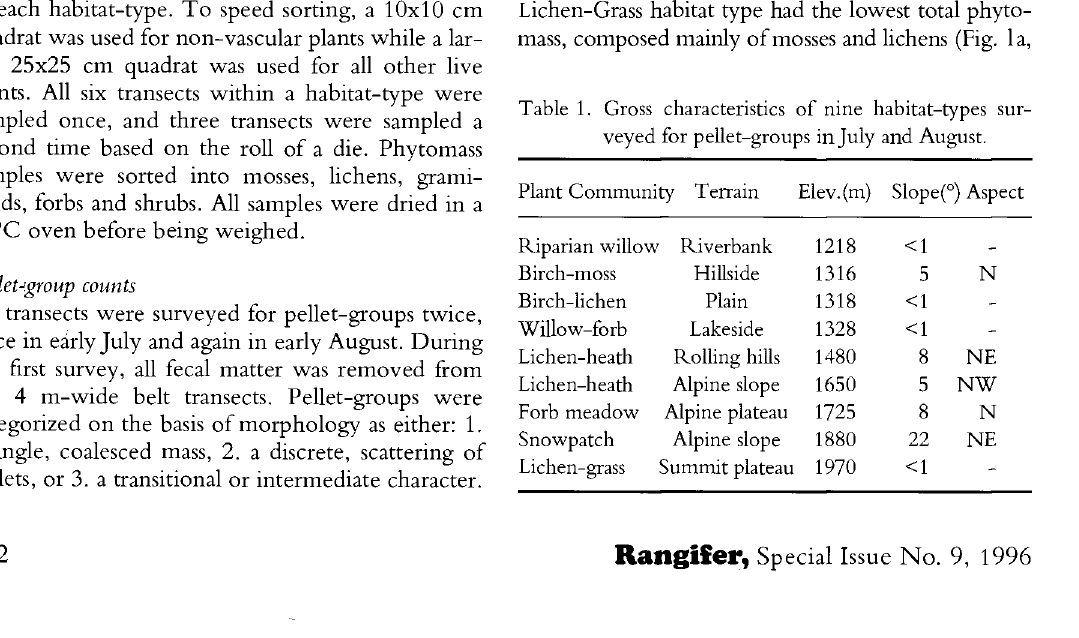
Table 1. Gross characteristics of nine habitat-types sur veyed for pellet-groups in July and